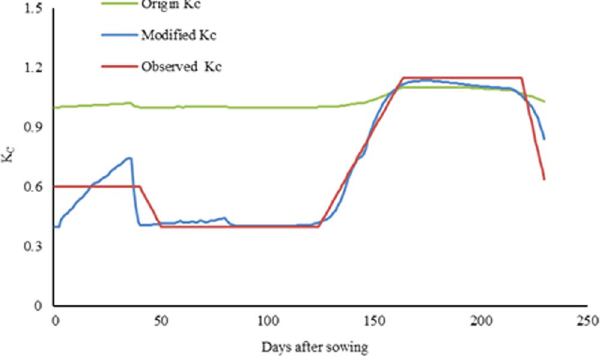
Figure 1. The crop coefficient curves from three methods in the 2015–2016 at the Experimental Station located in Xinxiang, Henan Province,